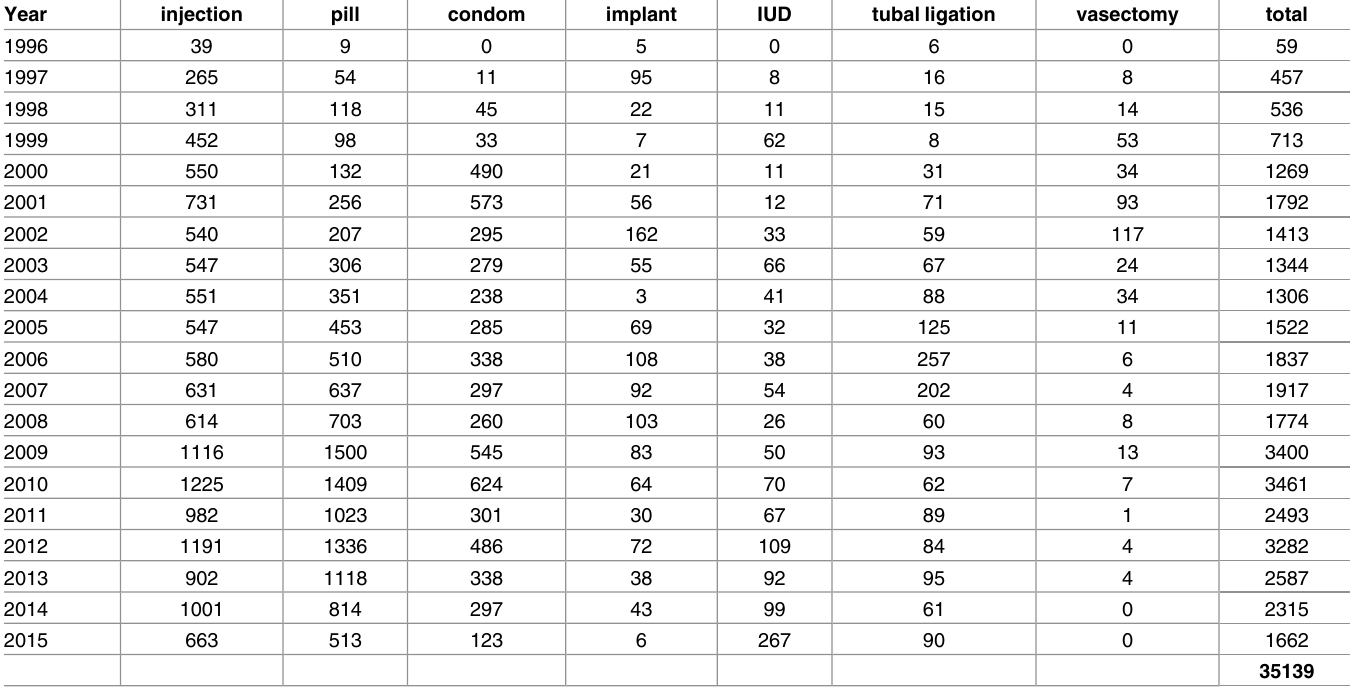
Table 1. New family planning consultations by year and contraceptive type by PPAT and